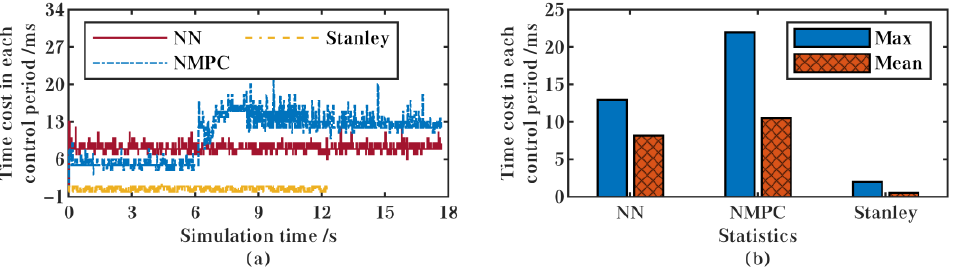
Figure 8. The real-time performance of the comparison simulation: ( a ) the time-series diagram; ( b ) the statistical diagram.